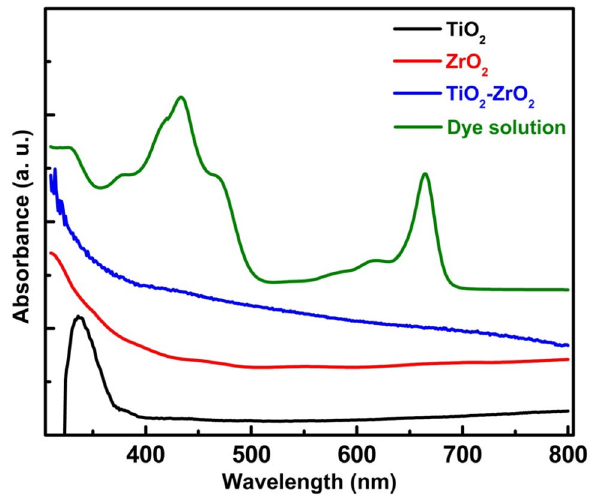
Fig. 2 Optical absorption spectra of TiO ( − ) films and ethanolic solution of dye ( −